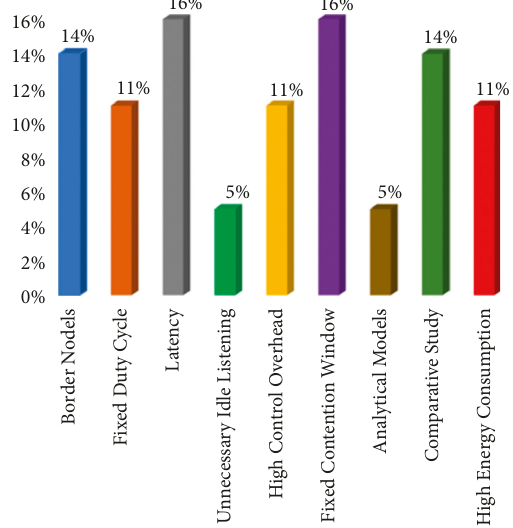
Figure 8: Distribution of publications on improved SMAC limitations.